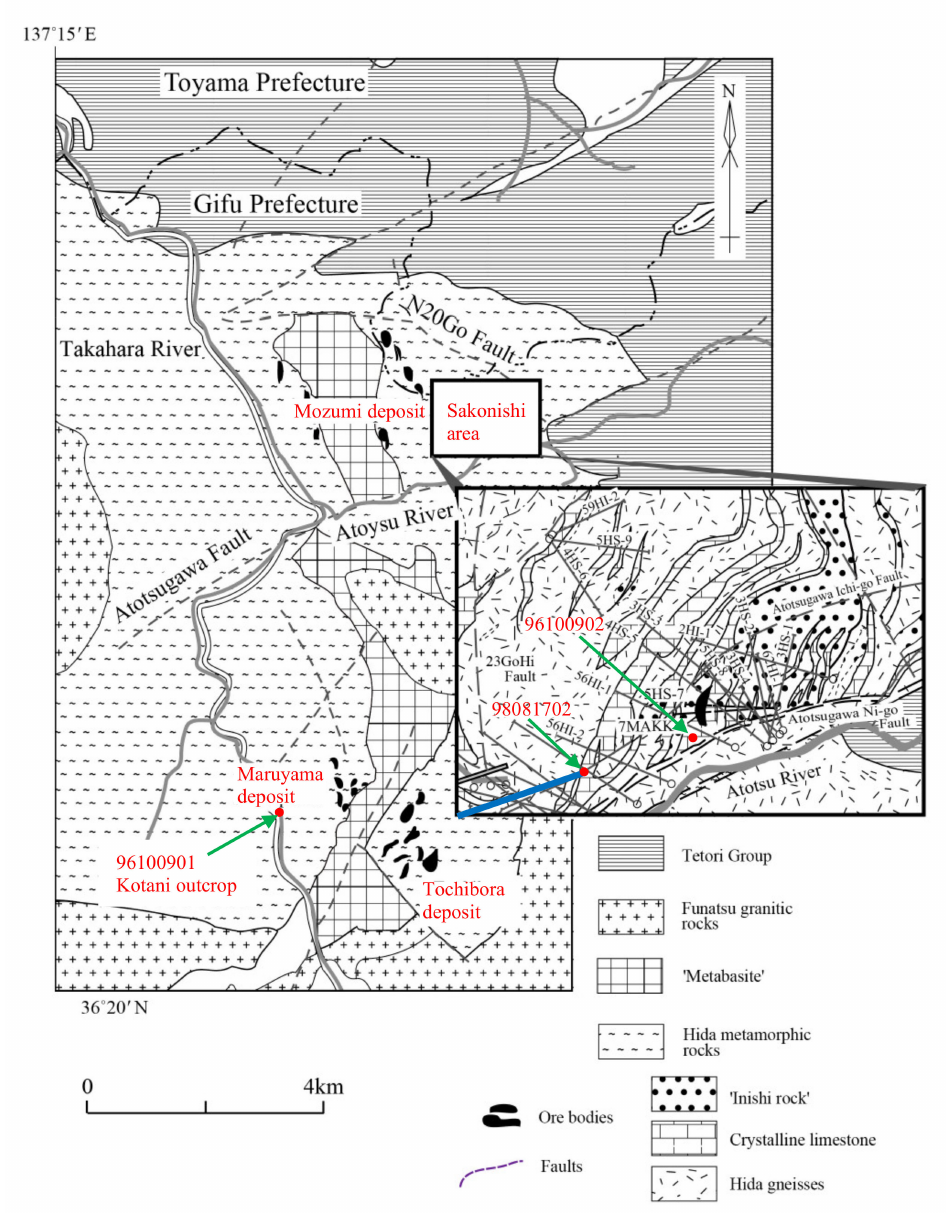
Figure 1. Geological map of the Kamioka mining district in the Hida metamorphic terrain (modified from [2]: Reproduced with permission from Resource Geology; published by the Society of Resource Geology). The localities of the major deposits (the Tochibora, Mozumi, and Maruyama deposits) and the Sakonishi area are shown. The localities of 96100901 (Kotani outcrop) and the Sakonishi samples (96100902 and 98081702) are shown. Drill holes in the Sakonishi area are shown in the rectangular insertion, and the drill hole collars are indicated with circles. The exploration adit in blue is at − 500 mL (350 m above sea